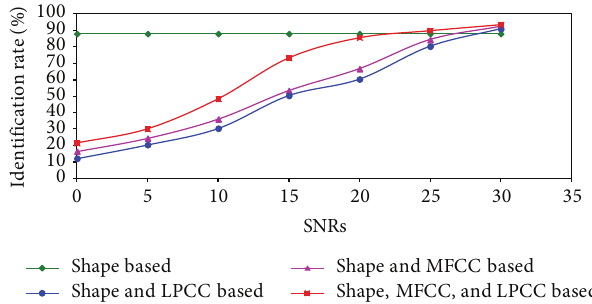
Figure 5: Result of various combinations of audio features with shape based facial feature.